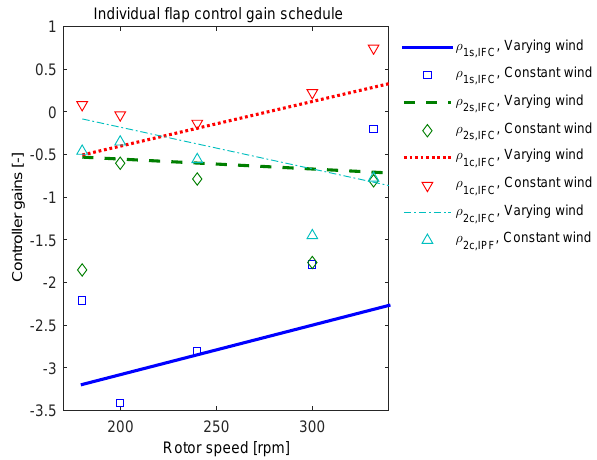
Figure 23. Optimisation of gain schedule slopes for varying wind speed conditions.